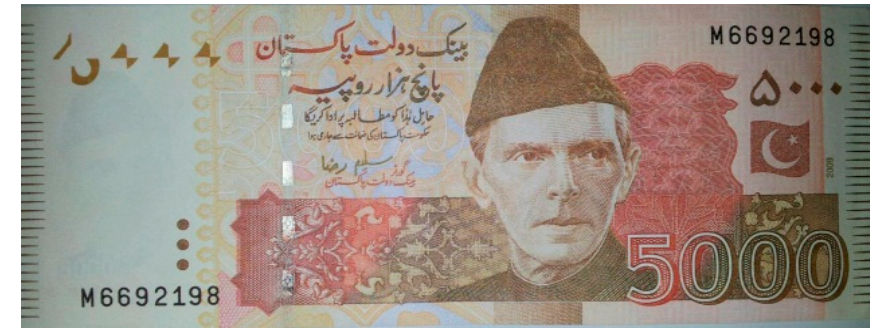
Figure 2. Counterfeit banknote.